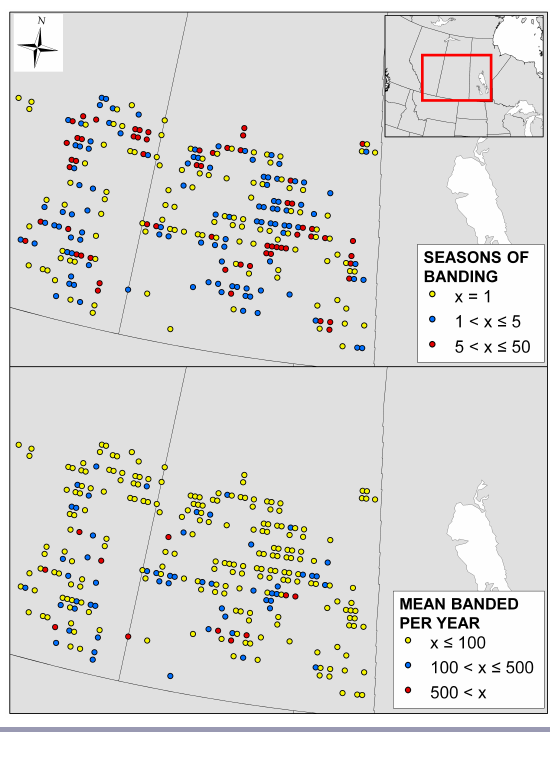
Fig. 2. Locations of banding sites for Northern Pintail ( Anas acuta ) in Alberta and Saskatchewan, Canada (≤ 54° N latitude) from 1960–2014. The colors vary by the number of seasons banding occurred at each site (top) and the mean number of Northern Pintail individuals banded per year of banding at that site (bottom). Inset shows the focal area in the context of the northern prairie region of North America.